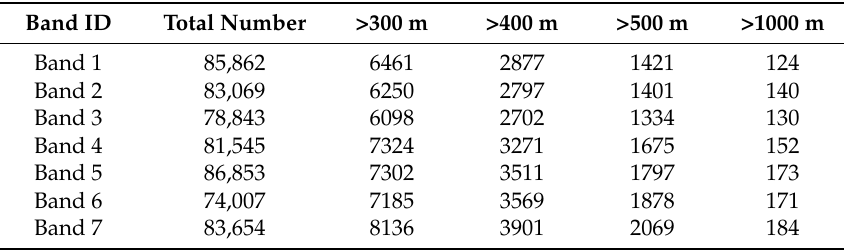
Table 6. Numbers of detected lines with different lengths using the vertical direction gradient data with a resolution of 30